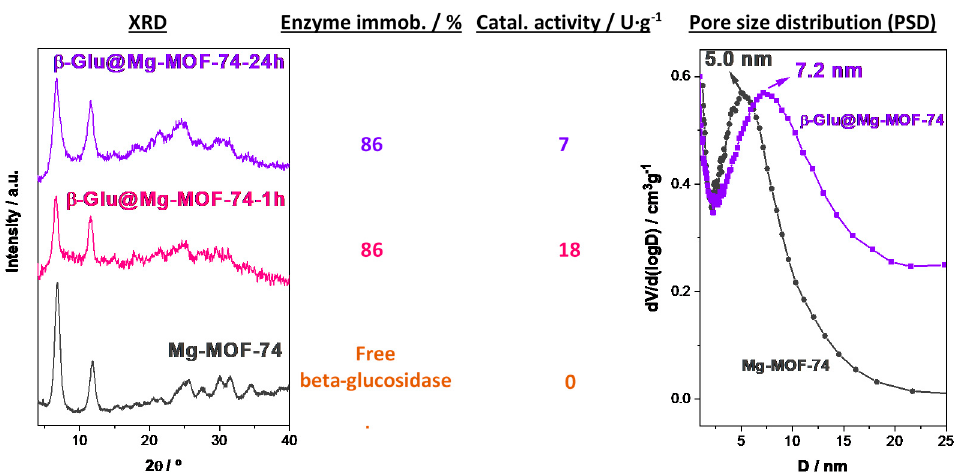
Figure 4. XRD patterns, enzyme immobilization (in percentage), catalytic activity (in activity units per g of biocatalyst in the hydrolysis of para -nitrophenyl- β - D -glucopyranoside) and PSD curves of the biocatalysts prepared by in situ immobilization of the enzyme β -glucosidase ( β -Glu) on Mg-MOF-74 in DMF after 1 or 24 h. The activity of the free enzyme in contact with DMF and the maximum of the PSD peaks are indicated. Data extracted from ref.